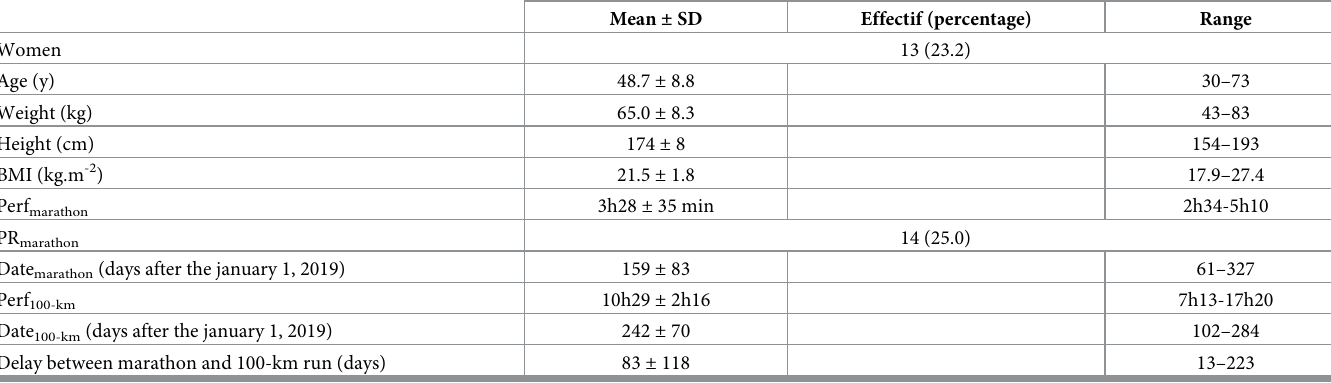
Table 1. Characteristics of 56 athletes and their performances in marathon and